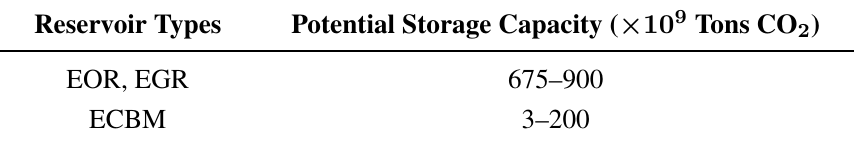
Table 3. Capacity of CO storage by enhanced oil recovery (EOR), enhanced gas recovery 2 (EGR) and enhanced coal-bed methane